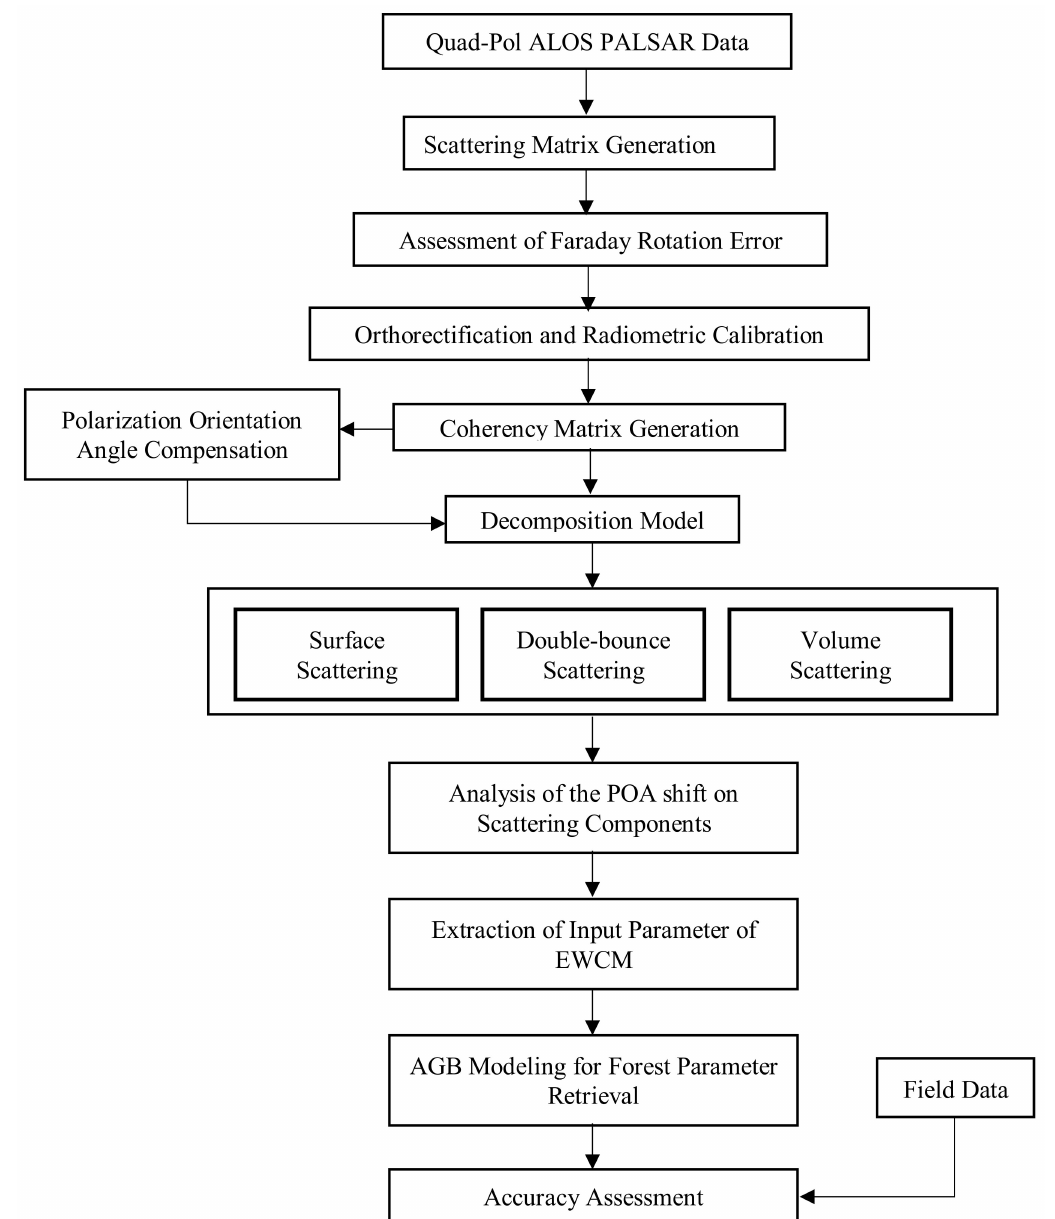
Figure 4. Methodology